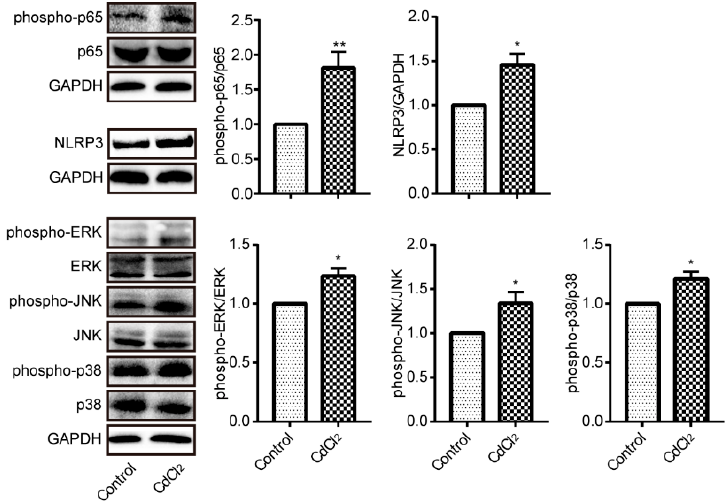
Figure 5. Cd activated nuclear factor- κ B (NF- κ B), Nod-like receptor 3 (NLRP3), and mitogen-activated protein kinases (MAPKs) in mouse liver ( n = 4). Phosphorylation of p65, ERK, JNK and p38 and the expression of NLRP3 were evaluated by Western blotting. * p < 0.05, ** p < 0.01 compared to control.